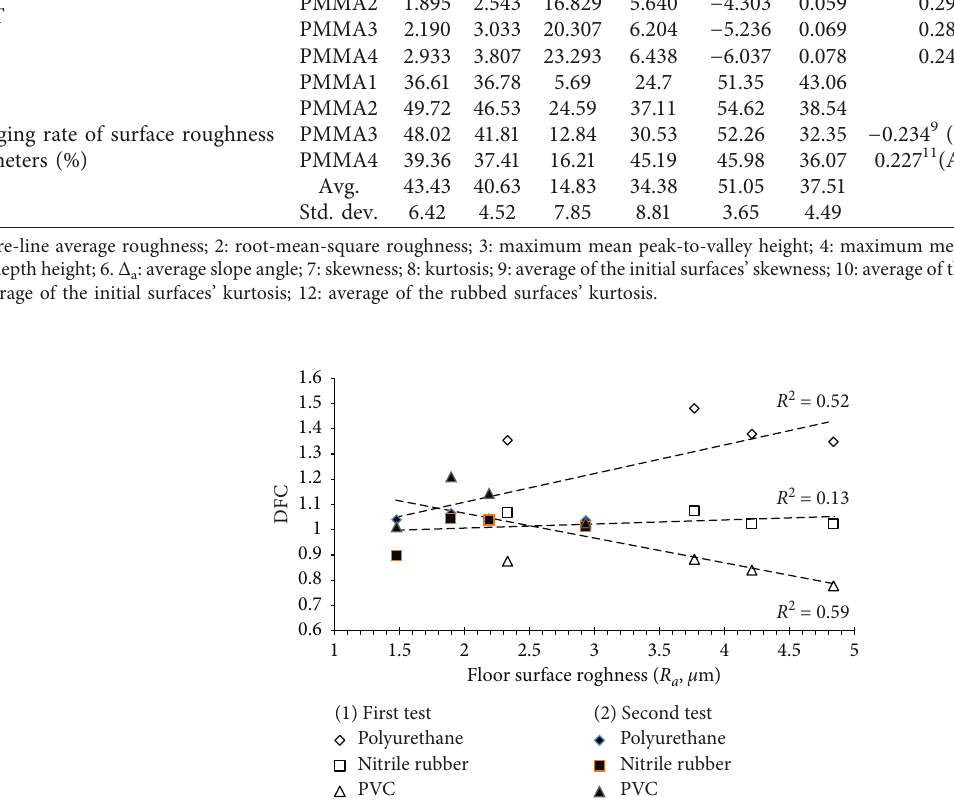
Figure 3: A result of dynamic skid-resistance measurements between the four PMMA specimens and three shoes: (1) average of first ten rubbings and (2) average of second ten rubbings, respectively.